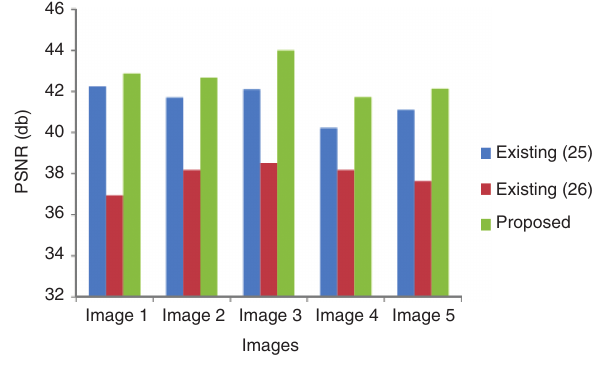
Figure 7: Comparative Analysis Based on PSNR Measure.